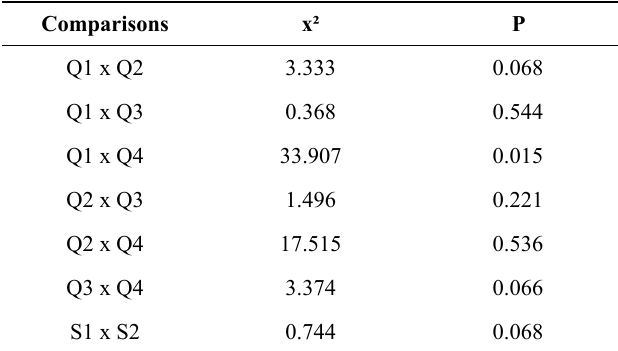
Table 5 – Values of chi-square and p for comparisons related to birth-